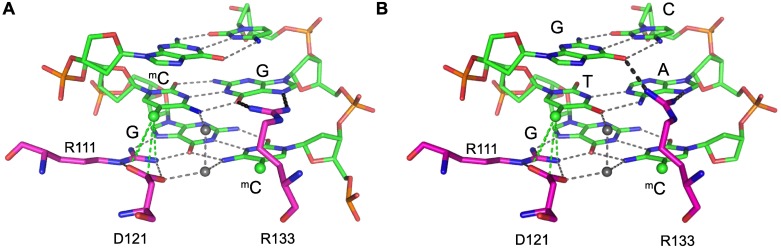
Hypothetical modeling of MeCP2 tri-nucleotide recognition suggests that flexibility may depend on the R133 side chain and require the methyl group of thymine.(A) X-ray structure of MeCP2 [77–167] interaction with the mCG di-nucleotide in double-strand DNA [43]. Critical amino acids R111, R133 and D121 are shown in pink. Green sphere: methyl group; grey sphere: water molecule; green dotted lines (from R111 and D121): favorable interactions; grey dotted lines: hydrogen bonds. (B) Modeling of the MeCP2 [77–167] interaction with double-strand DNA containing mCAC. Key as in (A) and black dotted lines: modeled interactions. See extended legend to S6 Fig for rationale.